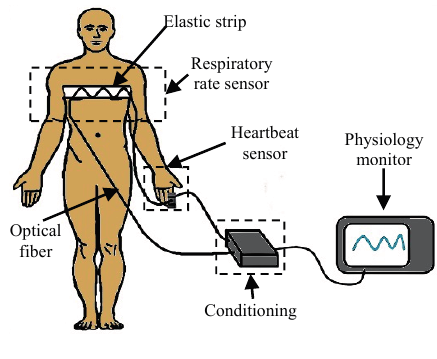
Figure 4. Diagram of the respiratory rate and heartbeat sensors placed on the isolated patient.